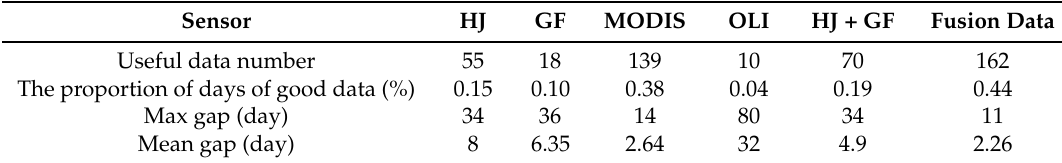
Table 9. The proportion of days with good data in each sensor in Luntai.